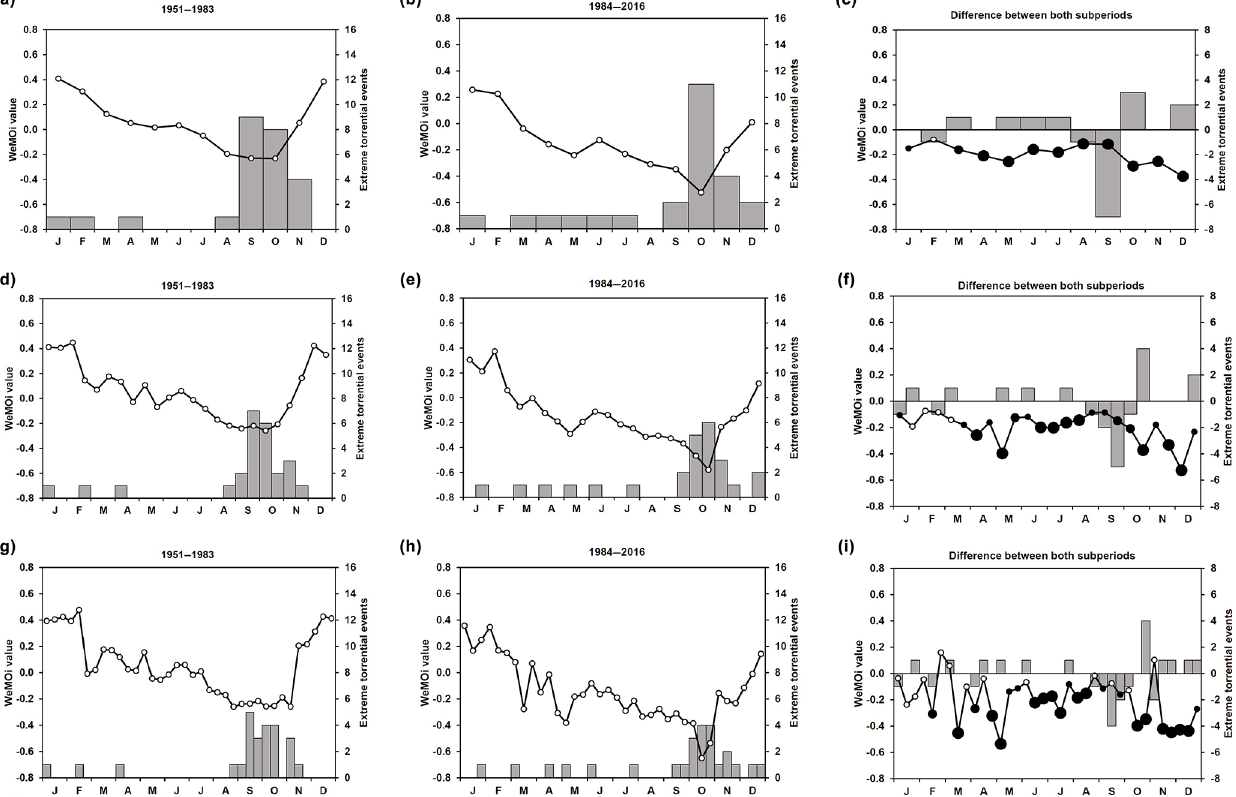
Figure 9. WeMOi calendars (lines) and frequency of extreme torrential episodes (bars) at several timescales: monthly (a–c) , fortnightly (d–f) and 10d (g–i) for the 1951–1983 (a, d, g) and 1984–2016 (b, e, h) subperiods. Panels (c, f, i) show the difference in the number of episodes and WeMOi values between both subperiods (for WeMOi values: white dots indicate not statistically significant differences, and small-, medium- and large-sized black dots show statistically significant differences at the 95.0%, 99.0% and 99.9% confidence levels,